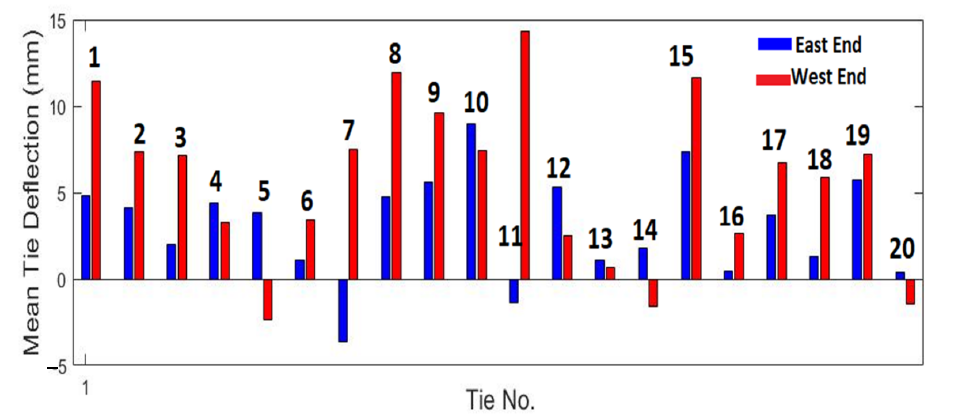
Figure 20. Mean tie end deflections of the first 20 ties computed over four test runs. Figure 21 shows the standard deviation for the first 20 ties.